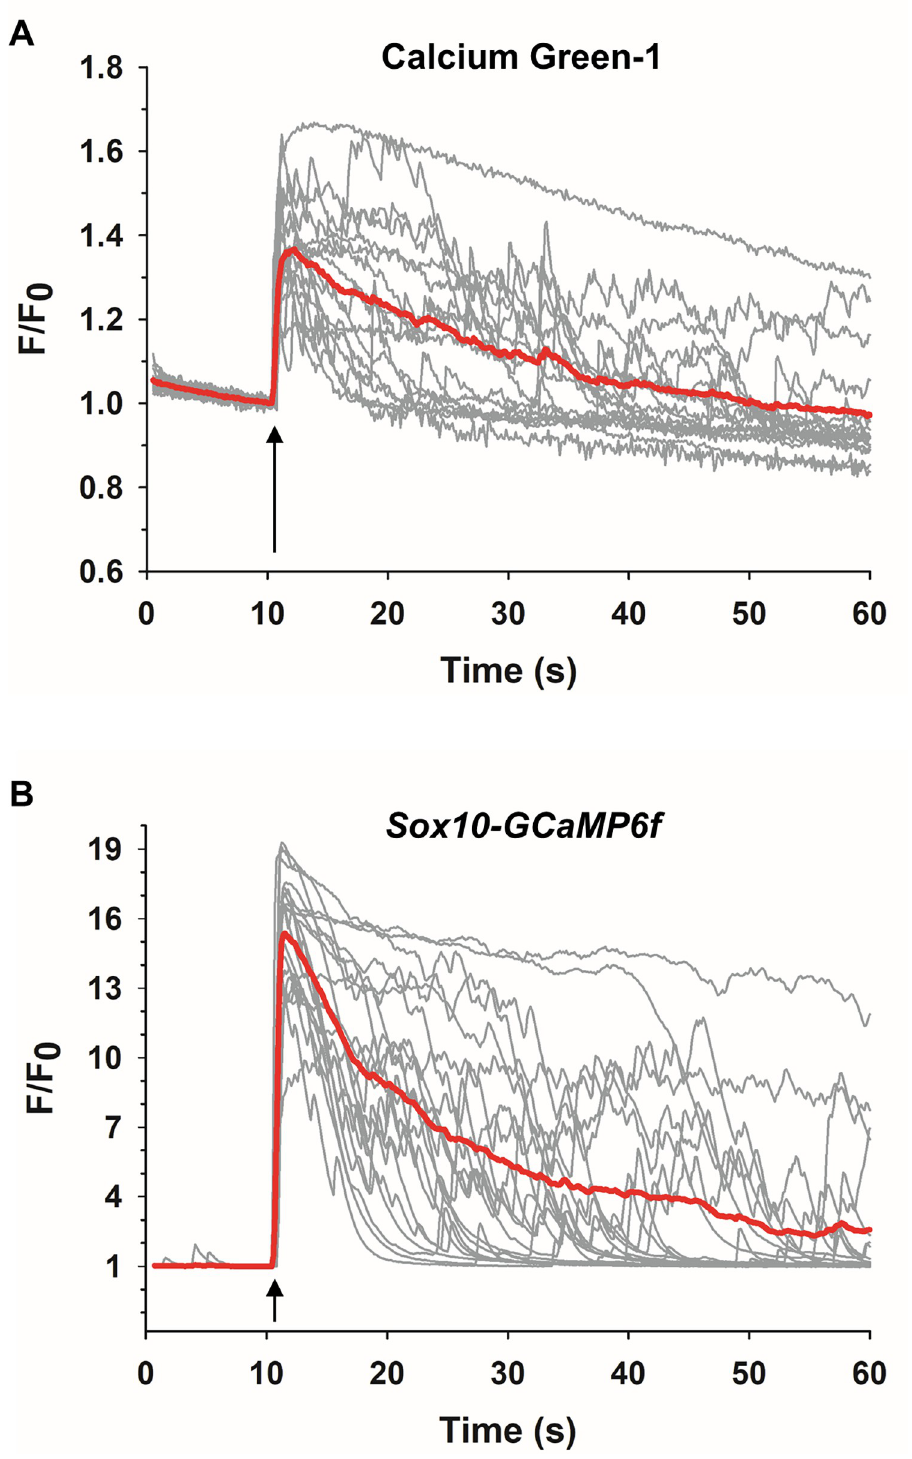
Fig 4. Comparison of Ca 2+ responses to DMPP in wt and GCaMP-expressing ACC derived from Sox10-GCaMP6f mice. (A) Ca 2+ responses to 50 μ M DMPP (arrows) in dye-loaded wt ACC ( n = 2, c = 17) and (B) in GCaMP6f- expressing ACC ( n = 3, c = 21). Traces show individual cell responses together with the averaged response (red lines). In (A), photobleaching is evident by the drop in fluorescence intensity below F/F 0 = 1.